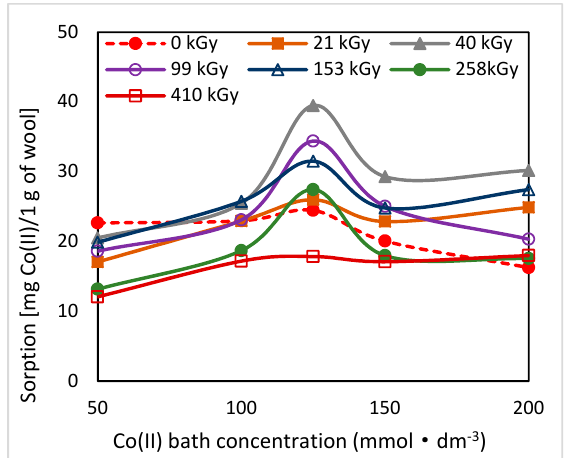
Figure 2. Variation of sorption of Co(II) on the wool samples depending on the initial bath concentration measured 65 days after the irradiation.